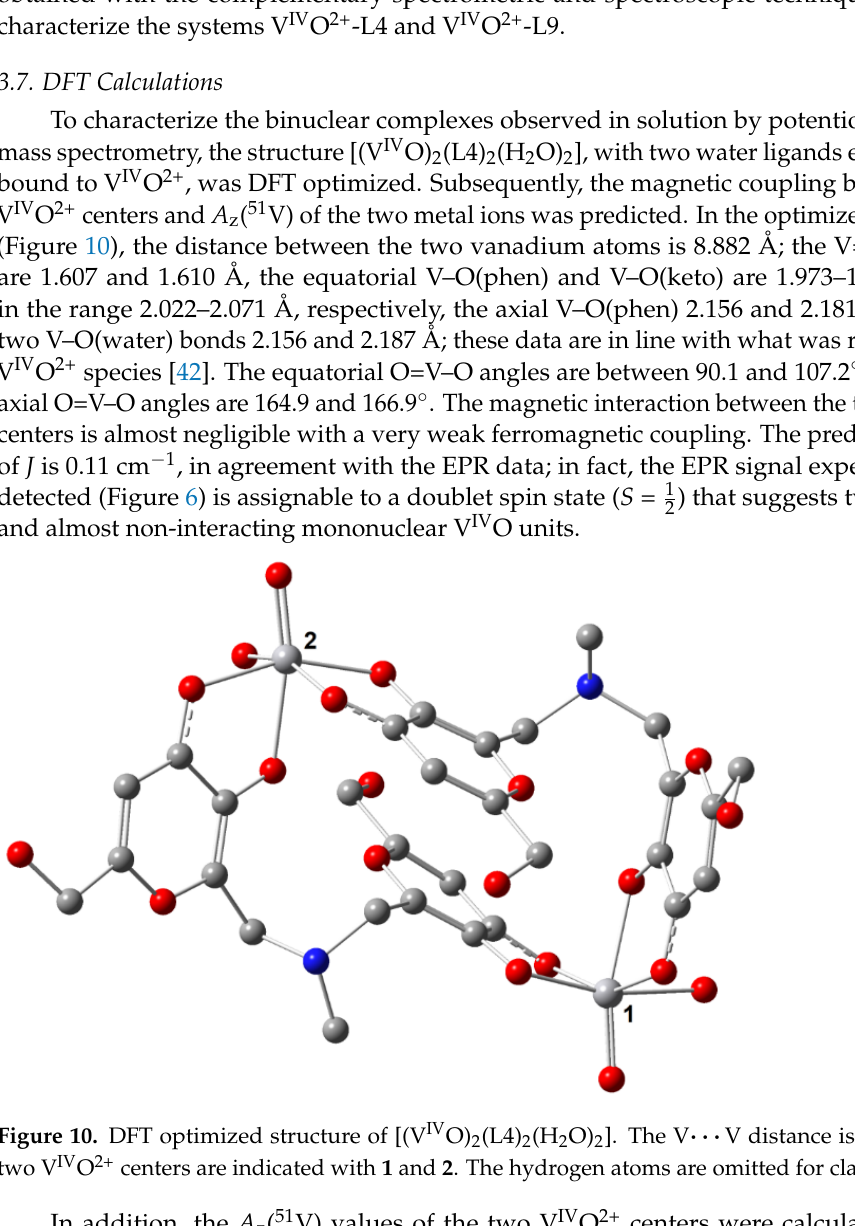
Table 4 . Experimental and calculated hyperfine coupling constants for [(V IV O) 2 (L4) 2 (H 2 O) 2 ] .